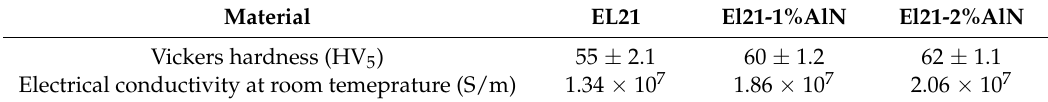
Table 1. Vickers hardness and electrical conductivity of El21 and its composites at ambient